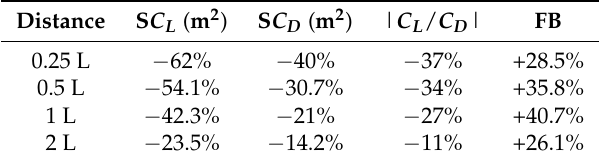
Figure 15. Comparison between values of front balance under wake flows and under free stream conditions. Table 5. Percentage of change of the aerodynamic coefficients of the second car as regards the first